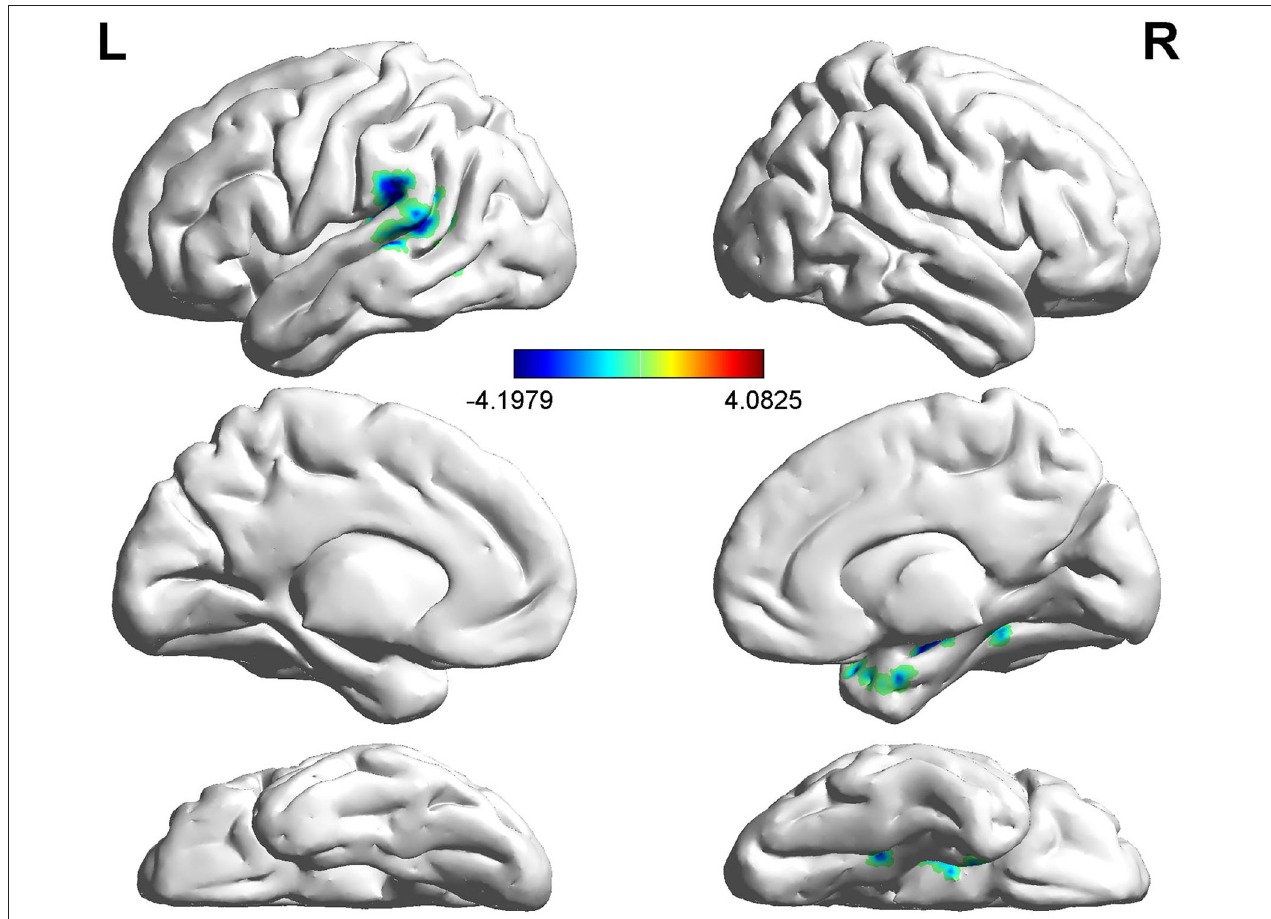
FIGURE 2 | Comparison of fractional ALFF (fALFF) between two groups. The figure showed decreased fALFF in the right hippocampus and left STG (two-tailed voxel-level p < 0.01 and cluster-level p < 0.05, GRF correction). Cbe9, cerebellum 9; CbeCru2, cerebellum crus2; STG: superior temporal gyrus; GRF: Gaussian Random